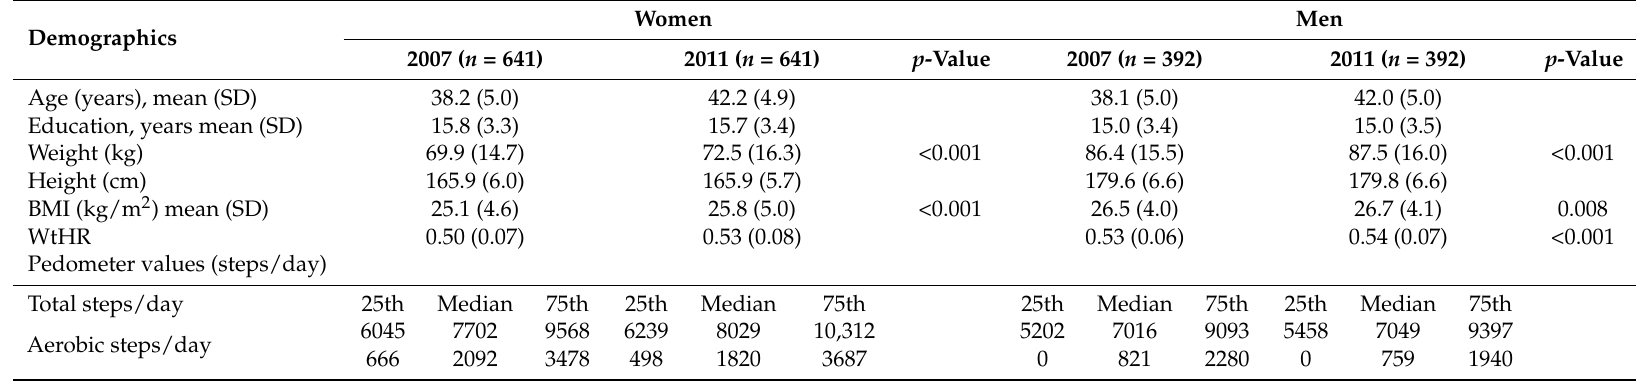
Table 2. Baseline characteristics of the study participants in 2007 and 2011 ( N =